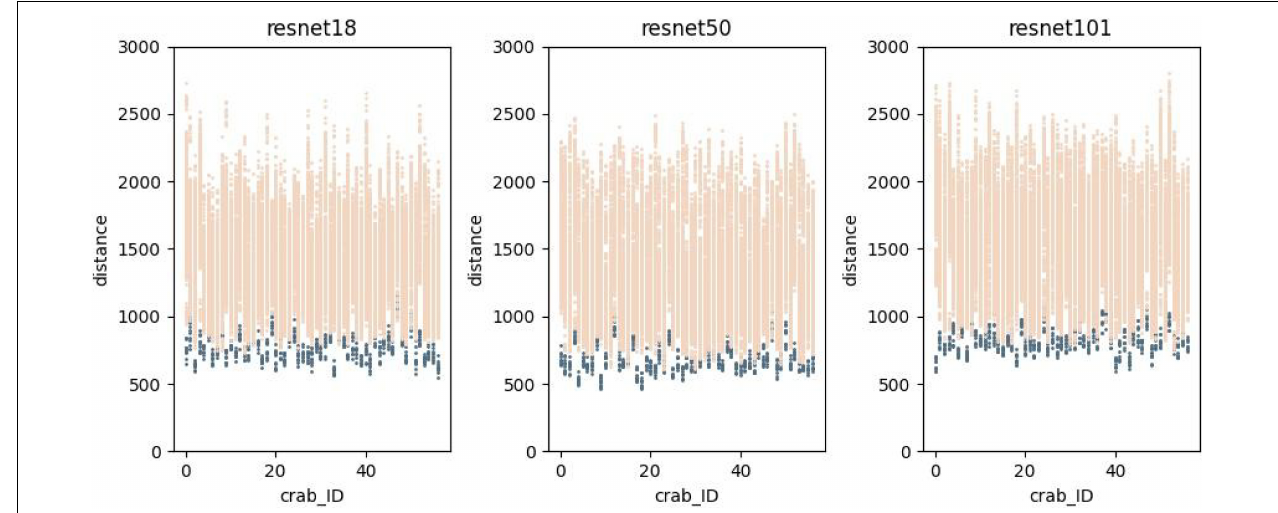
FIGURE 8 | The feature distance of P. trituberculatus in the query set to the other images in the gallery set.